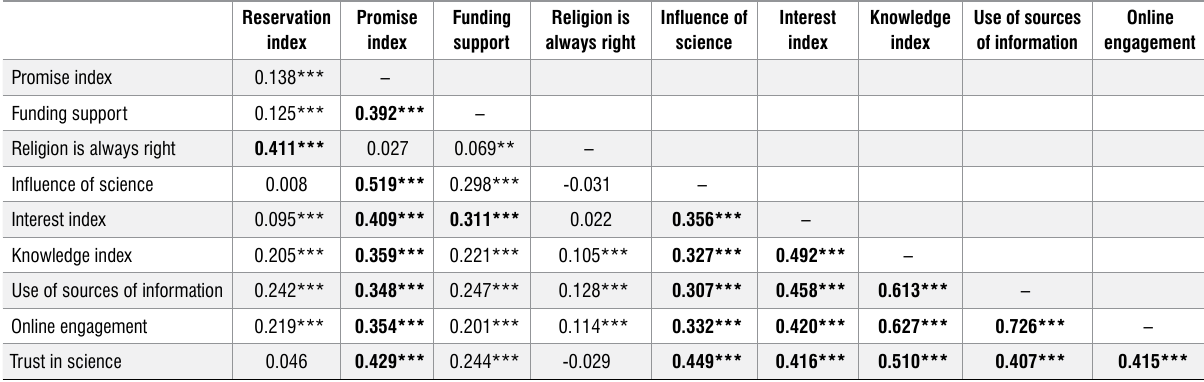
Correlations between the reservation and promise index and influential variables Reservation